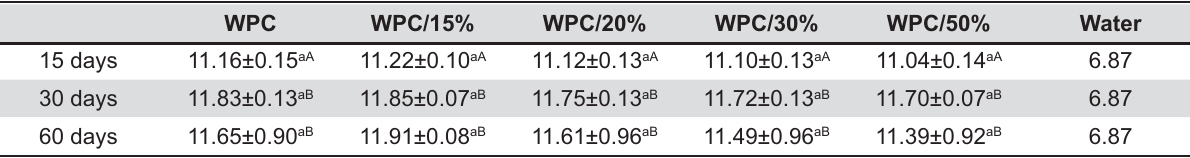
Table 1- Means and standard deviations of the assessed pH in the evaluated periods. Different lowercase letters in rows (cid:2)(cid:3)(cid:4)(cid:2)(cid:5)(cid:6)(cid:7)(cid:8)(cid:9)(cid:10)(cid:7)(cid:6)(cid:7)(cid:2)(cid:10)(cid:7)(cid:2)(cid:5)(cid:6)(cid:11)(cid:11)(cid:12)(cid:9)(cid:10)(cid:2)(cid:13)(cid:3)(cid:2)(cid:14)(cid:5)(cid:6)(cid:3)(cid:7)(cid:9)(cid:4)(cid:2)(cid:15)(cid:15)(cid:8)(cid:16)(cid:8)(cid:3)(cid:5)(cid:8)(cid:10)(cid:9)(cid:6)(cid:17)(cid:18)(cid:3)(cid:13)(cid:9)(cid:7)(cid:19)(cid:8)(cid:9)(cid:17)(cid:6)(cid:7)(cid:8)(cid:16)(cid:2)(cid:6)(cid:11)(cid:10)(cid:9)(cid:2)(cid:3)(cid:9)(cid:8)(cid:6)(cid:5)(cid:19)(cid:9)(cid:20)(cid:8)(cid:16)(cid:2)(cid:18)(cid:4)(cid:9)(cid:21)(cid:20)(cid:22)(cid:23)(cid:24)(cid:23)(cid:25)(cid:26)(cid:24)(cid:9)(cid:27)(cid:2)(cid:15)(cid:15)(cid:8)(cid:16)(cid:8)(cid:3)(cid:7)(cid:9)(cid:28)(cid:20)(cid:20)(cid:8)(cid:16)(cid:5)(cid:6)(cid:10)(cid:8)(cid:9)(cid:11)(cid:8)(cid:7)(cid:7)(cid:8)(cid:16)(cid:10)(cid:9)(cid:2)(cid:3)(cid:9) (cid:5)(cid:18)(cid:11)(cid:28)(cid:17)(cid:3)(cid:10)(cid:9)(cid:2)(cid:3)(cid:4)(cid:2)(cid:5)(cid:6)(cid:7)(cid:8)(cid:9)(cid:10)(cid:7)(cid:6)(cid:7)(cid:2)(cid:10)(cid:7)(cid:2)(cid:5)(cid:6)(cid:11)(cid:11)(cid:12)(cid:9)(cid:10)(cid:2)(cid:13)(cid:3)(cid:2)(cid:14)(cid:5)(cid:6)(cid:3)(cid:7)(cid:9)(cid:4)(cid:2)(cid:15)(cid:15)(cid:8)(cid:16)(cid:8)(cid:3)(cid:5)(cid:8)(cid:10)(cid:9)(cid:6)(cid:17)(cid:18)(cid:3)(cid:13)(cid:9)(cid:7)(cid:19)(cid:8)(cid:9)(cid:20)(cid:8)(cid:16)(cid:2)(cid:18)(cid:4)(cid:10)(cid:9)(cid:15)(cid:18)(cid:16)(cid:9)(cid:8)(cid:6)(cid:5)(cid:19)(cid:9)(cid:17)(cid:6)(cid:7)(cid:8)(cid:16)(cid:2)(cid:6)(cid:11)(cid:9)(cid:21)(cid:20)(cid:22)(cid:23)(cid:24)(cid:23)(cid:25)(cid:26)